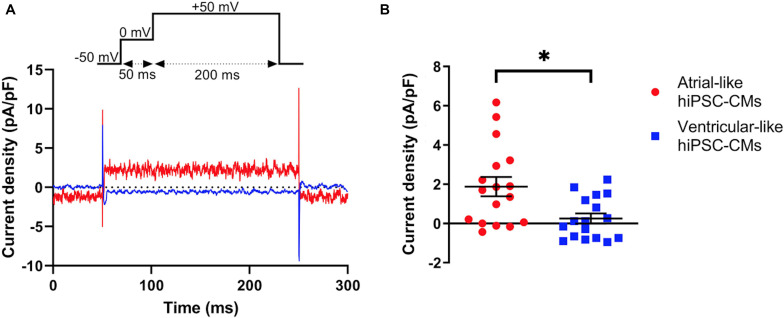
Density of IKur measured as 50 μM 4-AP-sensitive current. (A) Typical 4-AP-sensitive currents in an atrial- and a ventricular-like hiPSC-CM (red and blue traces, respectively) upon 200-ms depolarizing voltage clamp steps to +50 mV from a holding potential of −50 mV. (B) IKur density in 17 atrial- and 17 ventricular-like hiPSC-CMs. *P < 0.05.